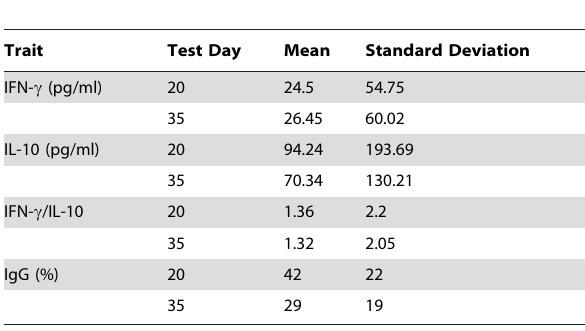
Table 3. Descriptive statistics of the traits in the study